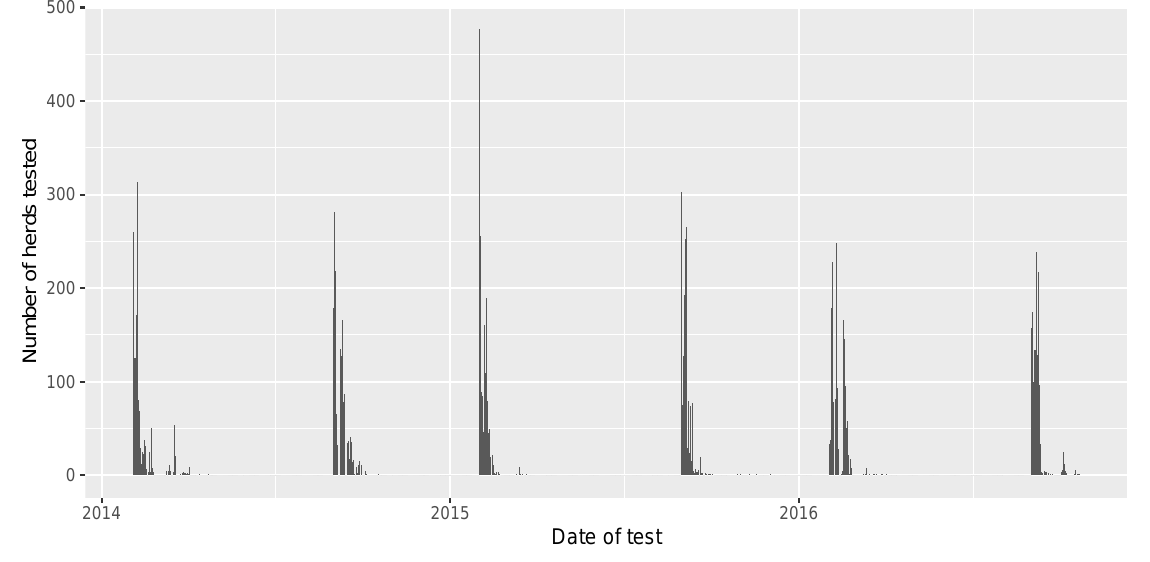
Figure 4 – Distribution of the test dates between 2014 and 2017 in 1687 herds from Loire-Atlantique,